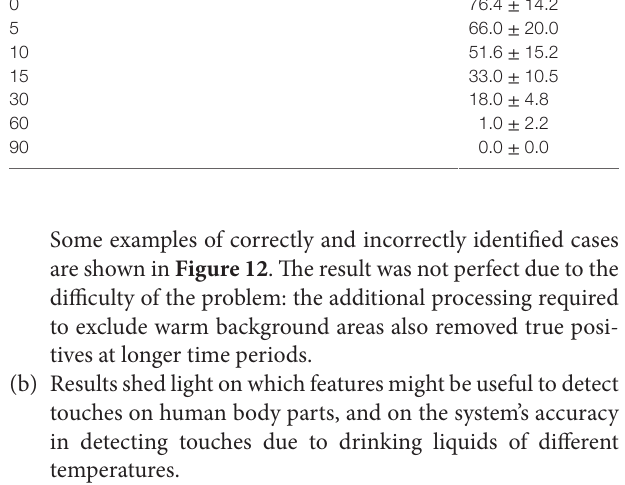
TaBle 3 | Detection accuracies of heat traces on objects over time. Time (s)